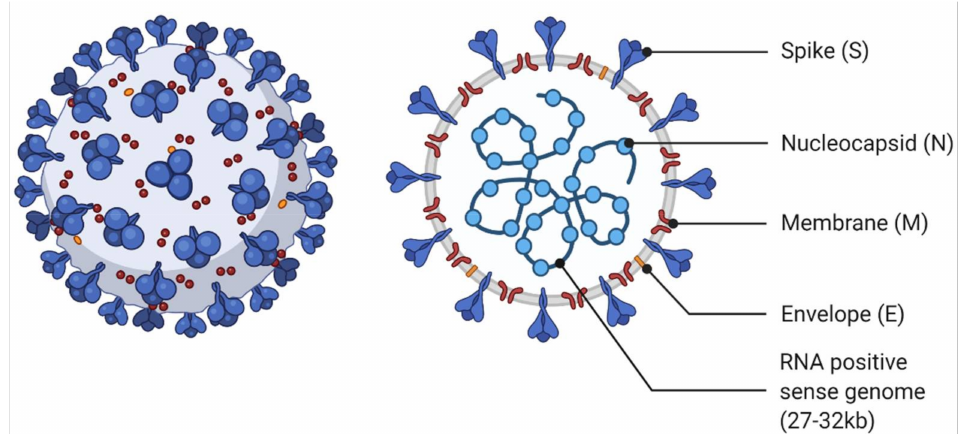
Figure 1. Coronavirus virion. The coronavirus virion contains the long (27–30 kb) viral single- stranded positive sense RNA genome encapsulated by the viral nucleocapsid (N) protein. The RNA/nucleocapsid complex is protected by the viral envelope comprised of viral envelope (E), membrane (M), and spike (S) proteins. The S protein includes the receptor binding domain (RBD) to target host cells. Created with